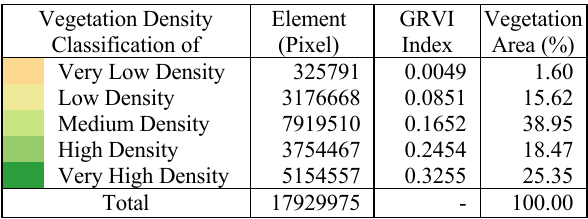
Tabel 3 . Classification result of the vegetation